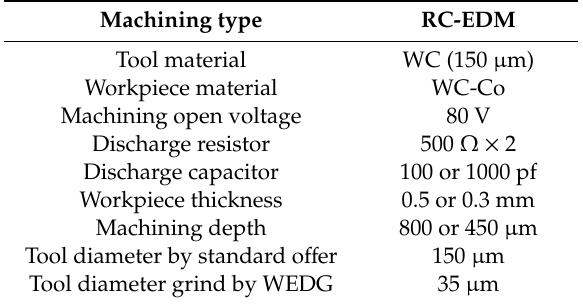
Table 2. Machining conditions of the desktop micro-EDM system.